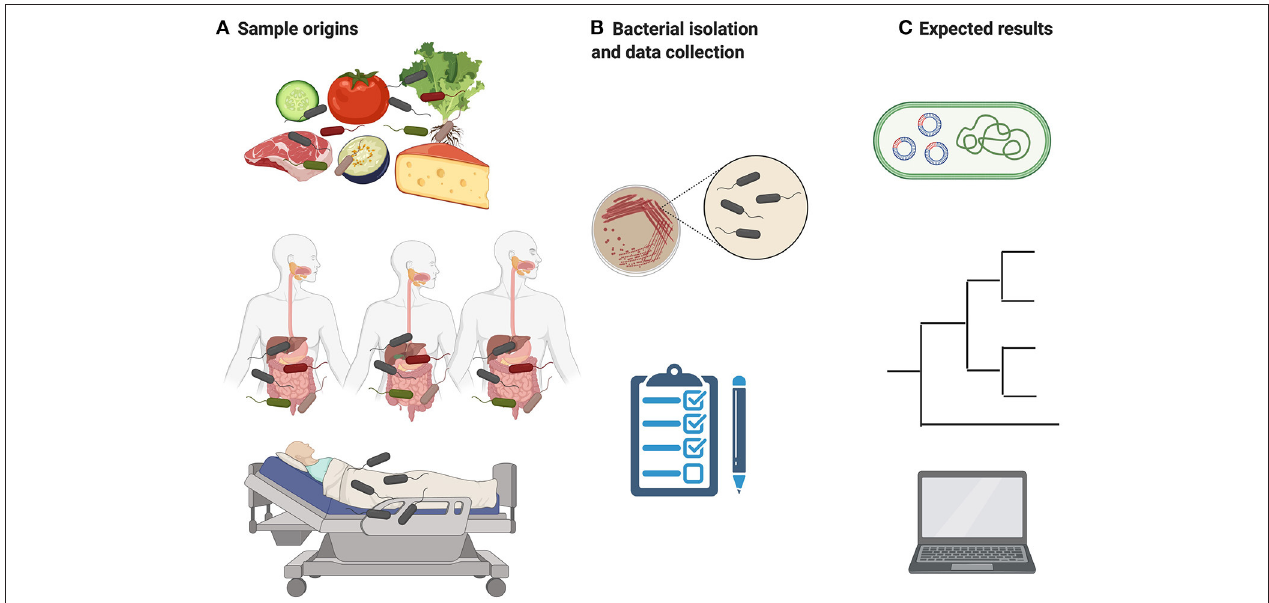
FIGURE 1 | Schematic representation of use of whole genome sequencing to determine genetic relatedness of clinically relevant resistant Enterobacterales (CRRE) presence in food and humans. (A) Samples from three distinct origins including different food types, human samples of cohort participants colonized in the community and samples from hospitalized patients with a bloodstream infection. (B) Isolation of CRRE from the origins in (A) along with data collection. (C) Expected results include identification of mobile elements and phylogenetic relatedness on CRRE from these three origins, and prediction of risk factors using computational analysis.